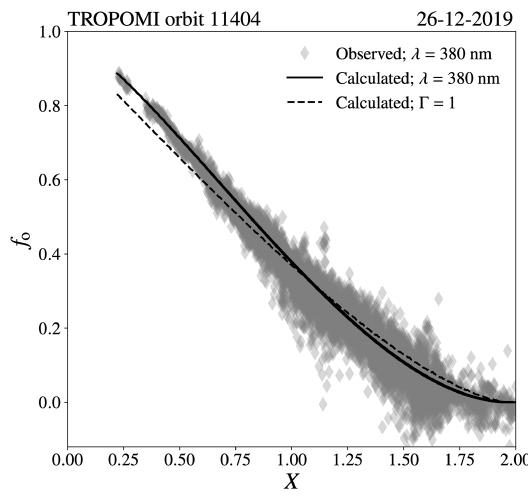
Figure 15. Similar to Fig. 14, but plotted against the disc centre separation X